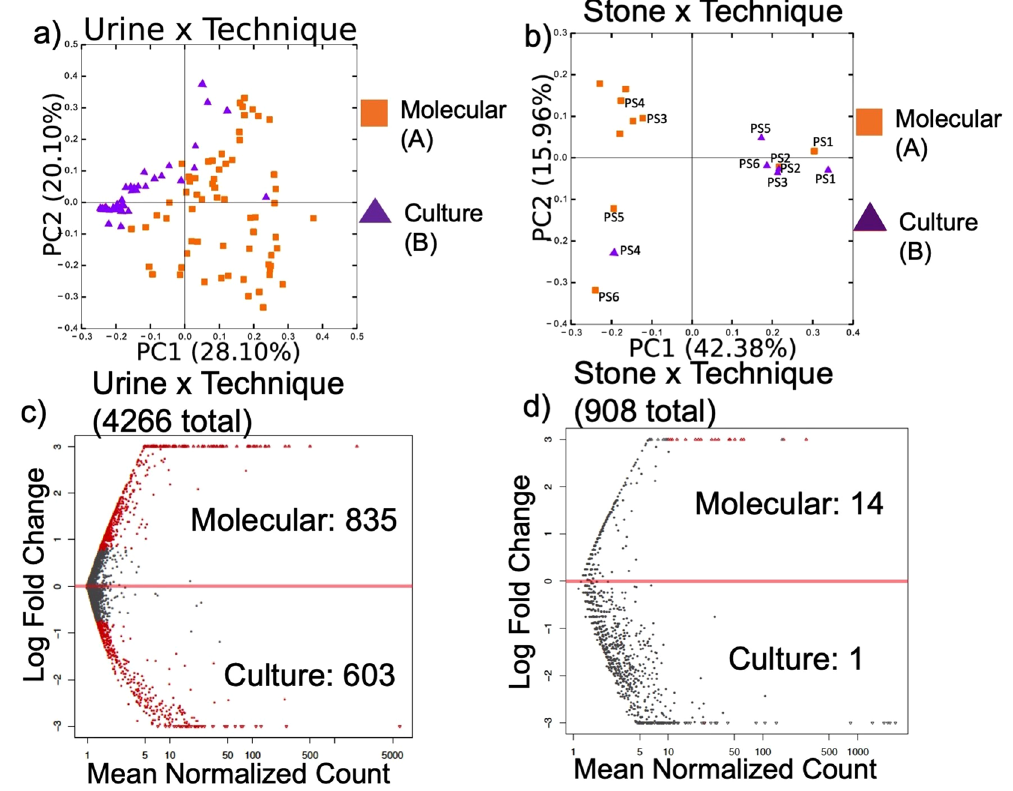
Figure 2. Microbiome analysis by technique. ( a , b ) PCoA plots based on a weighted UniFrac analysis by technique for bacterial analysis, with each principal component listed with % of the dissimilarity explained by the coordinate. Statistical significance was determined by an Adonis with 999 permutations. Letters denote differences with p < 0.05. PS = “Paired Sample” and indicates the paired stone samples (molecular vs. culture). ( c , d ) The differential abundance of OTUs by technique as assessed by a negative binomial Wald test. Red dots indicate significantly different OTUs (FDR < 0.05), gray dots indicate non-significant OTUs. Listed are the total number of OTUs defined within the group, along with the number of OTUs enriched in each specimen type by